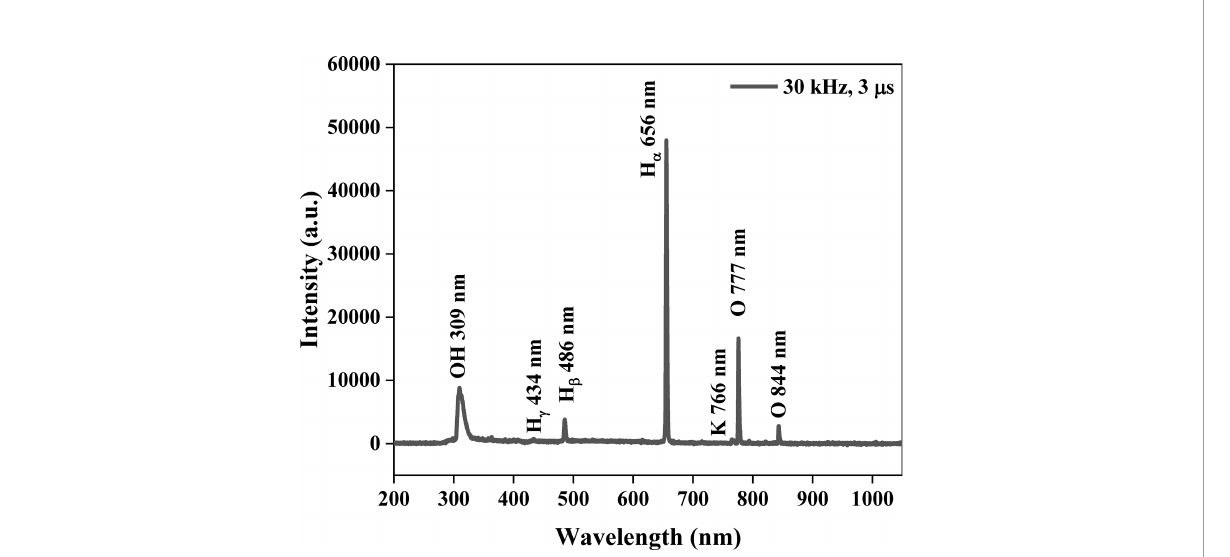
FIGURE 4 Identi fi cation of active species from liquid phase plasma in deionized water including 3 mM KCl by optical emission spectrometer at a frequency of 30 kHz and a pulse width of 3 m s. The major active species were atomic hydrogen ( l = 656 nm), atomic oxygen ( l = 777 nm), and hydroxyl radicals ( l = 309 nm).